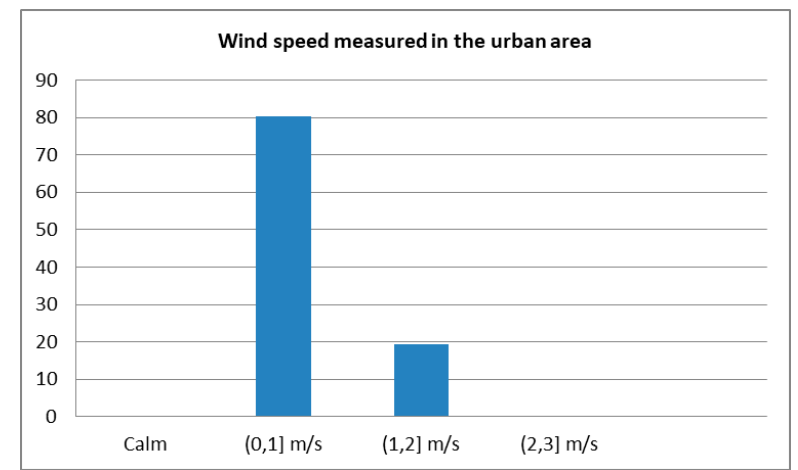
Figure 4. Relative Frequencies of the wind speed valued recorded in the center of Athens, during the experimental period.